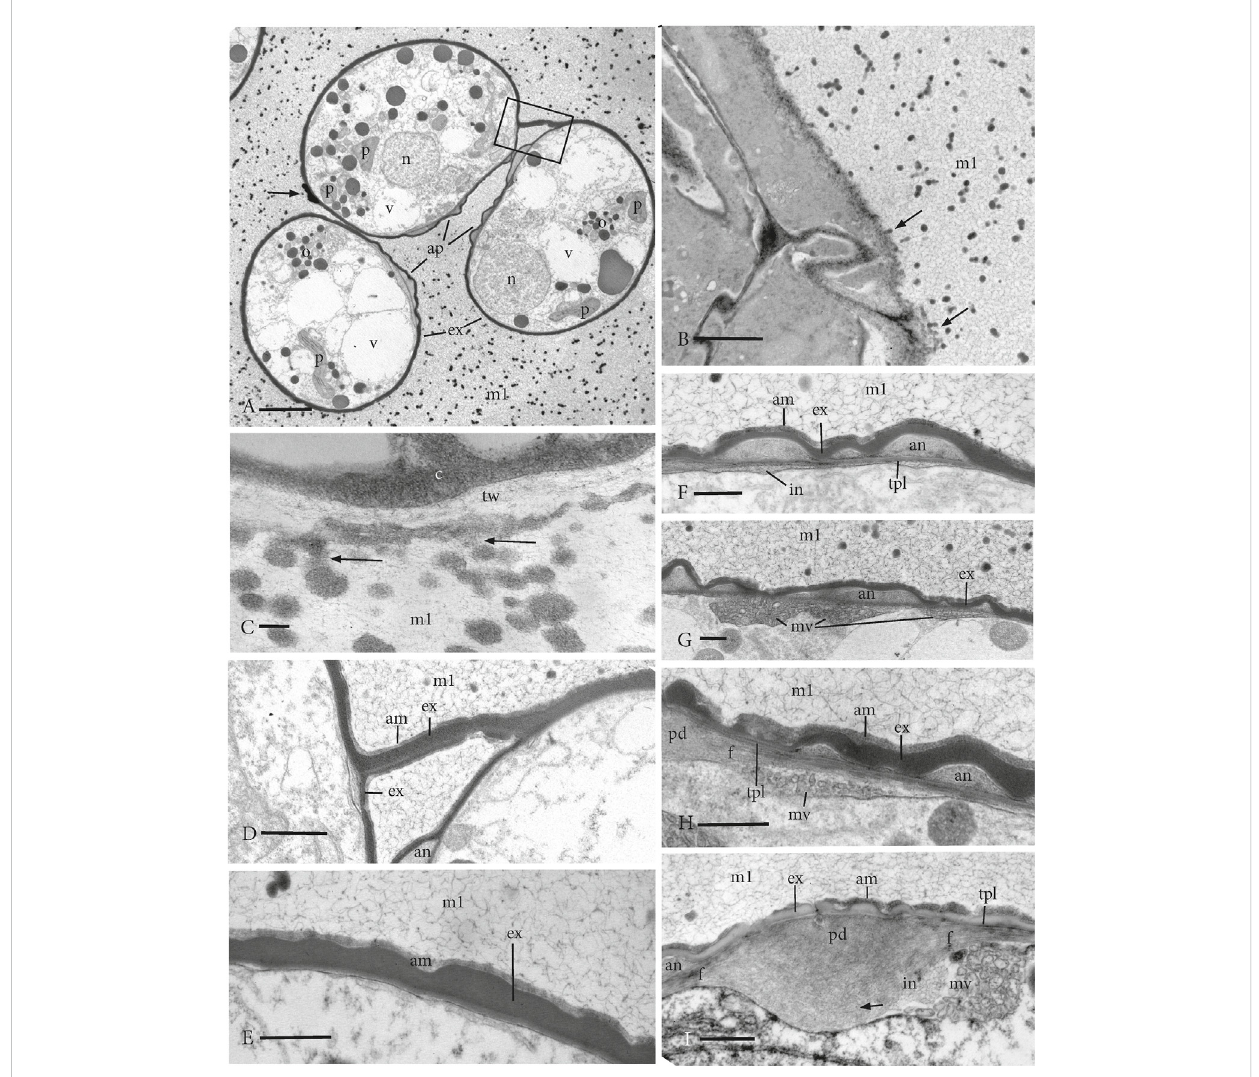
FIGURE 4 TEMs of young expanded free spores surrounded by sporopollenin globules distributed throughout the locule matrix (m1) that has merged with matrix 2 and the intersporal matrices. (A) Three spores in a tetrad that contain sparse cytoplasm with a nucleus (n), plastids (p), scattered oil droplets (o), and numerous vacuoles (v). The exine (ex) delimits the spore, and the apertures (ap) extend along the proximal surface of each spore. Apertures are sectionedonlyalongtheannulusregion,andnocentralpadisvisible.ThearrowdenotestheremnantoftheSMCwall,andtheboxoutlinesaportion of theSMC wall that connects adjacent spores. (B) Tapetal cells of theinner capsule wall containdense cytoplasm and are coated with materials (arrows) similartoglobulesintheloculematrix(m1). (C) Highermagni fi